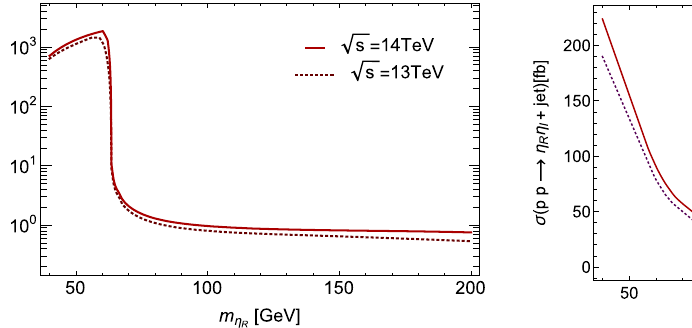
√ √ s = 13 ( 14 ) TeV. s = 13 ( 14 ) TeVrespectively. The right panelisthe Z-mediated fbfor process, pp → η R η I + jet, with peak contribution ∼ 190 ( 220 ) fb